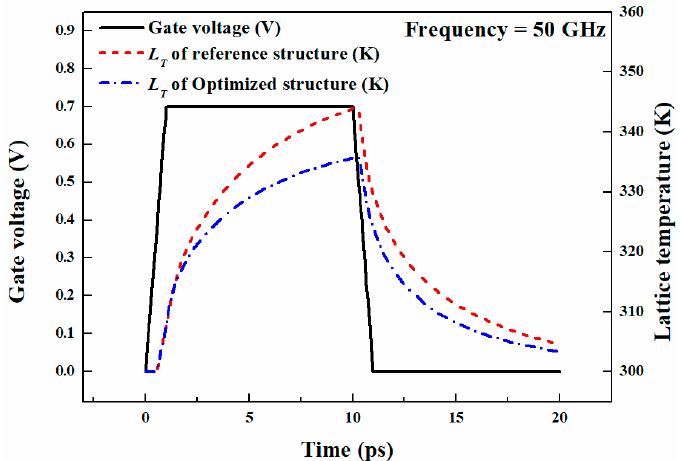
Figure 14. AC applied gate characteristics of the SHE, before and after optimization.